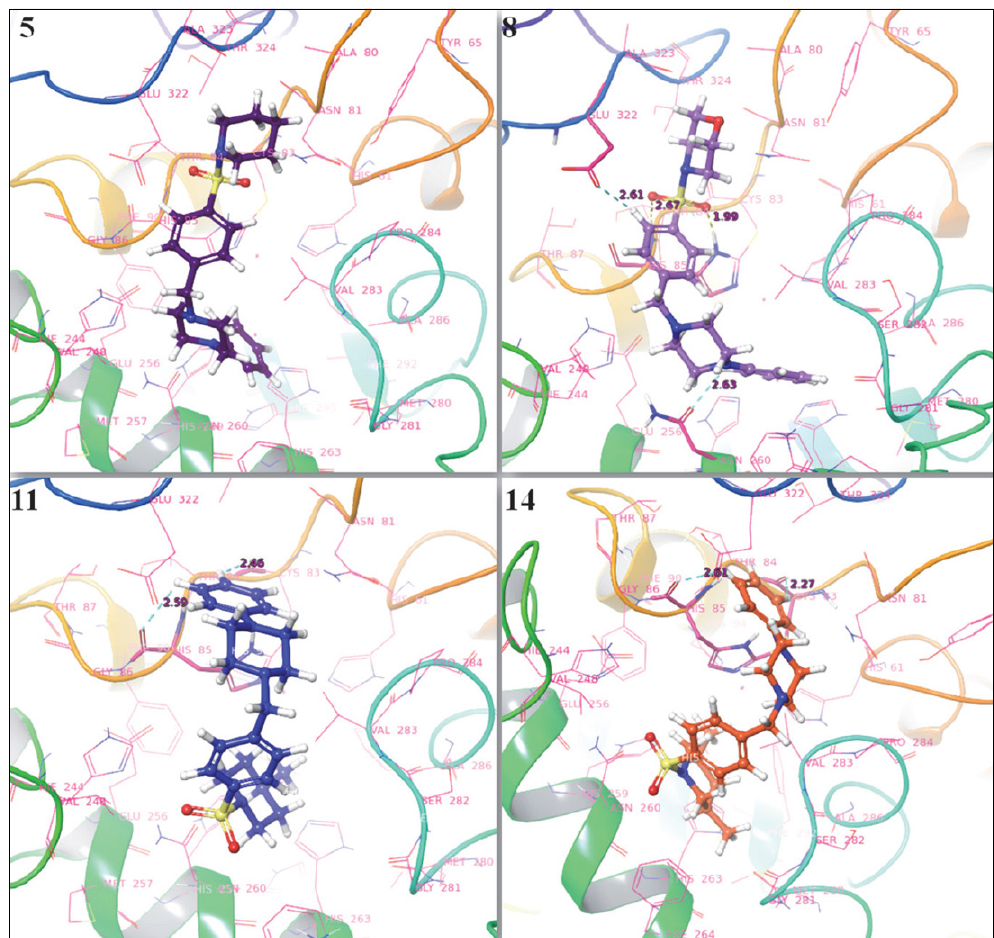
Figure 7. 3D binding interactions of 5 , 8 , 11 and 14 against tyrosinase protein.